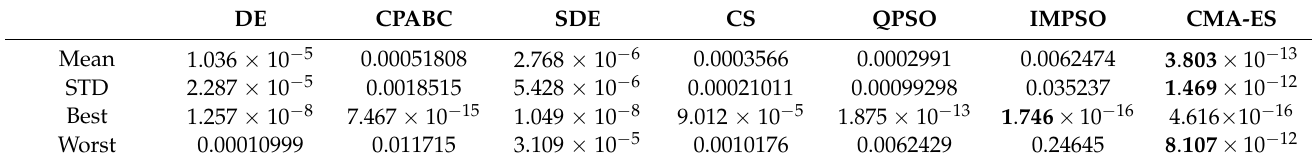
Table 5. Position error results for target point 2. The best results are highlighted in bold.